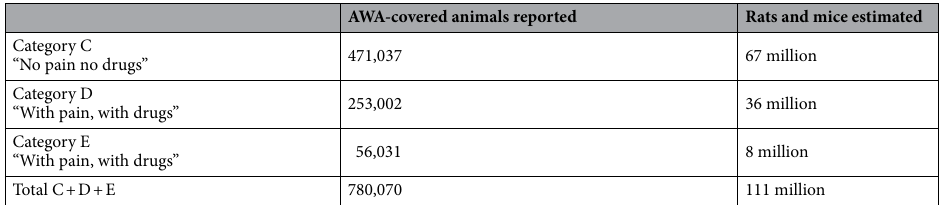
Table 2. Distribution of “used animals” in USDA “Pain Categories” C, D, and E: 2017–2018. AWA-covered animals and percentages from USDA’s summarized nationwide AWA statistics. Estimate of approximate numbers of RM used in each category if their pain categories are the same as AWA-covered animals, based on data that RM are approximately 99.3% of all mammals used in US laboratories. Category descriptors of pain and drug use are those used by the